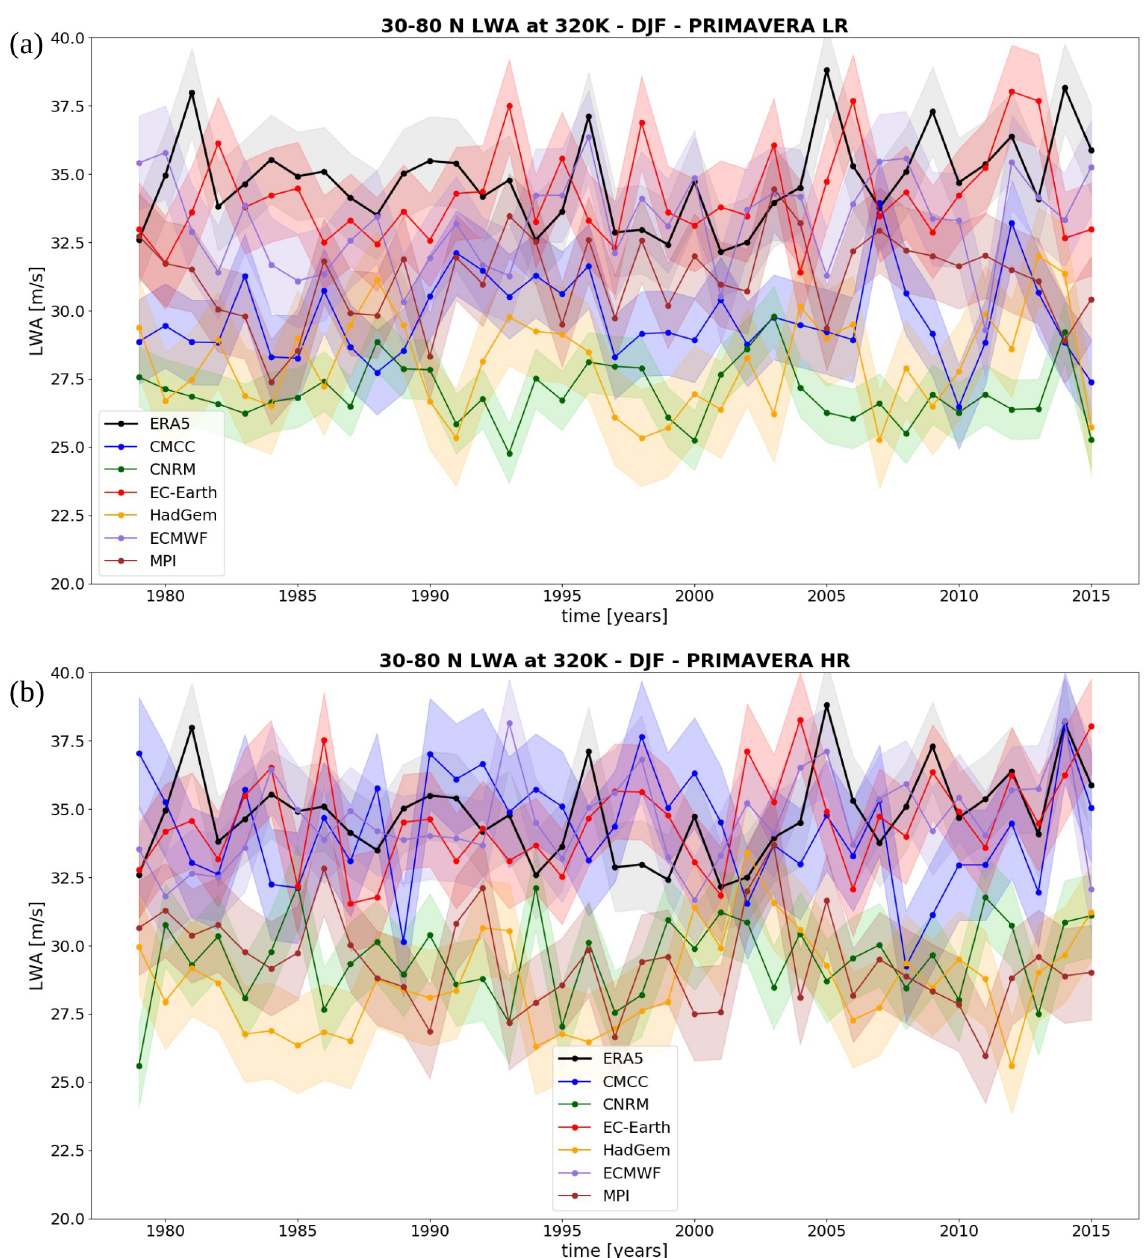
Figure 3. Time series of transient LWA averaged over the NH. Each dot represents the time-averaged value for each winter season (DJF). The black line is ERA5, and PRIMAVERA models are in colour. Shading is the range between 2 standard deviations from the mean for each time